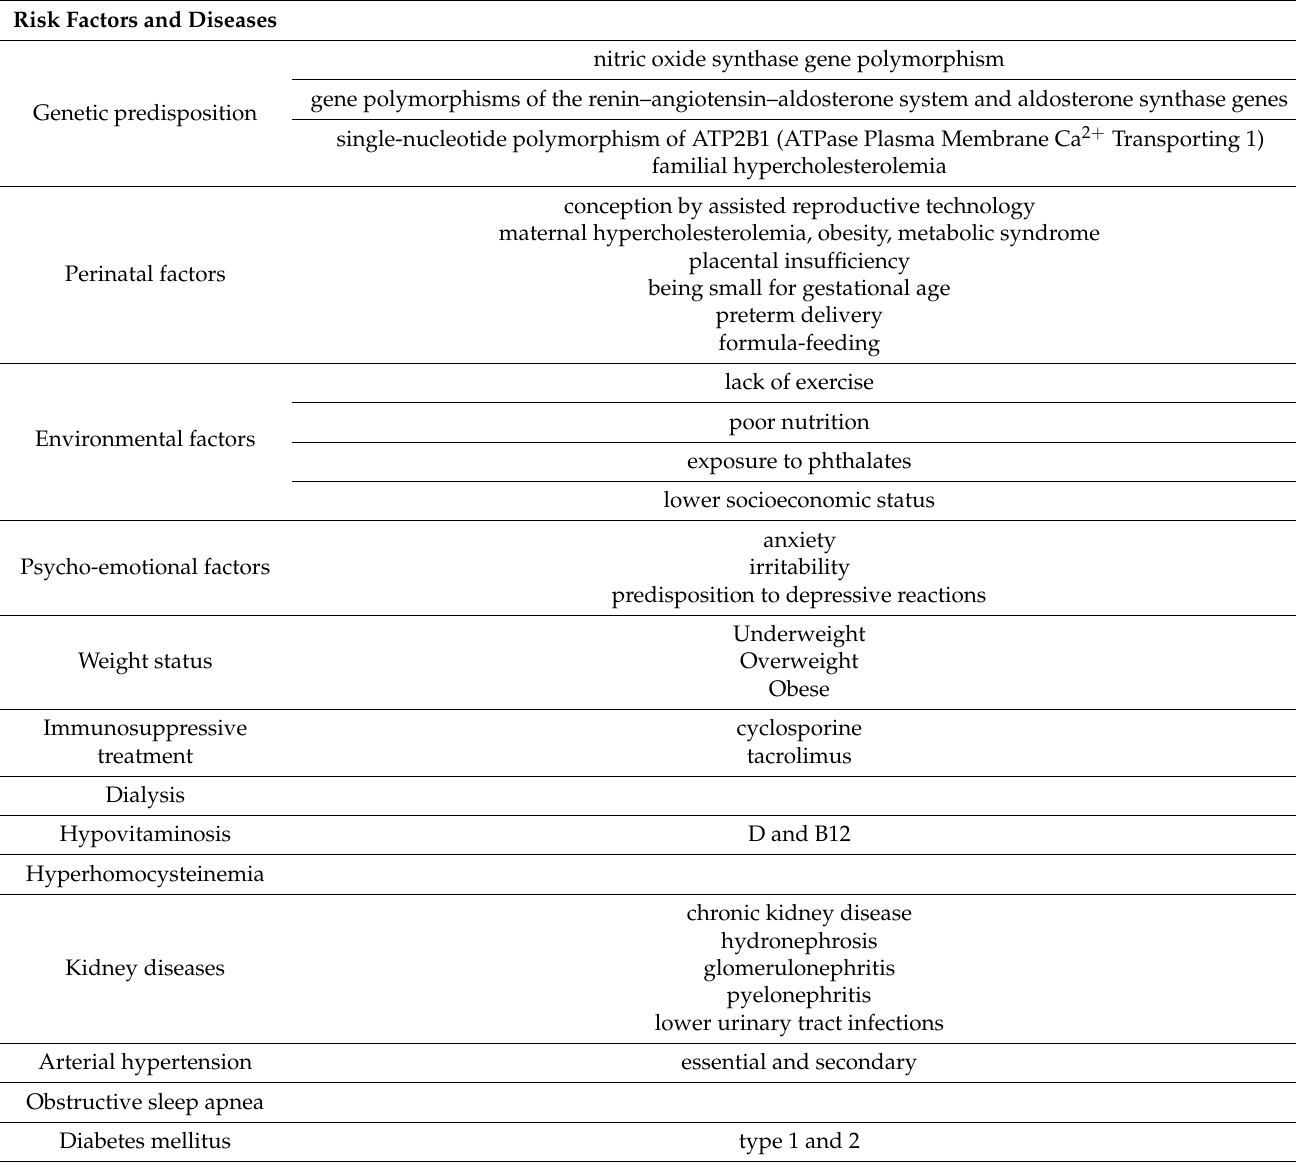
Table 2. Risk factors and diseases associated with oxidative stress, systemic inflammation and cardiovascular